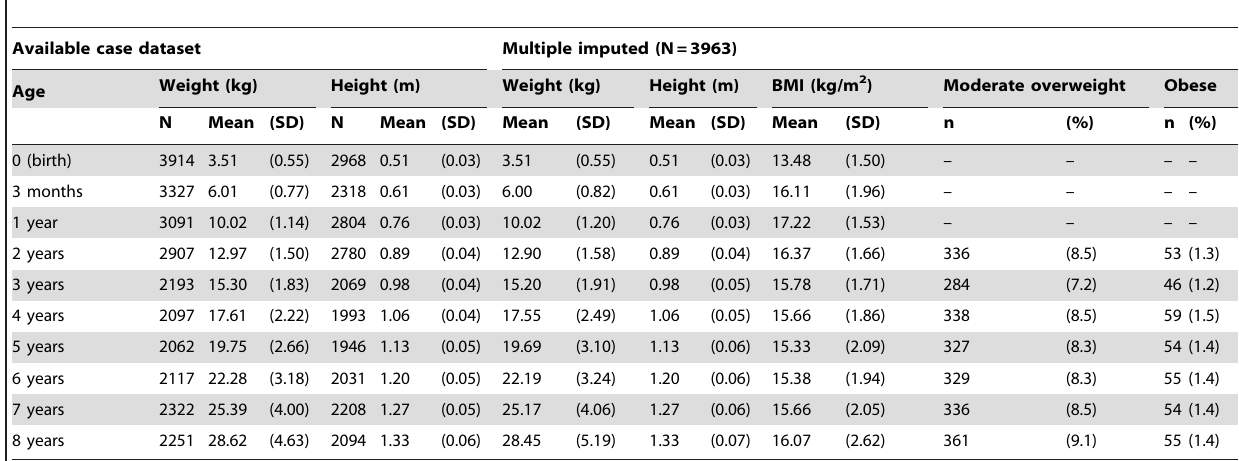
Table 2. Reported weight, height and BMI development from birth to 8 years of age and prevalence of moderate overweight and obesity from 2 to 8 years of age.